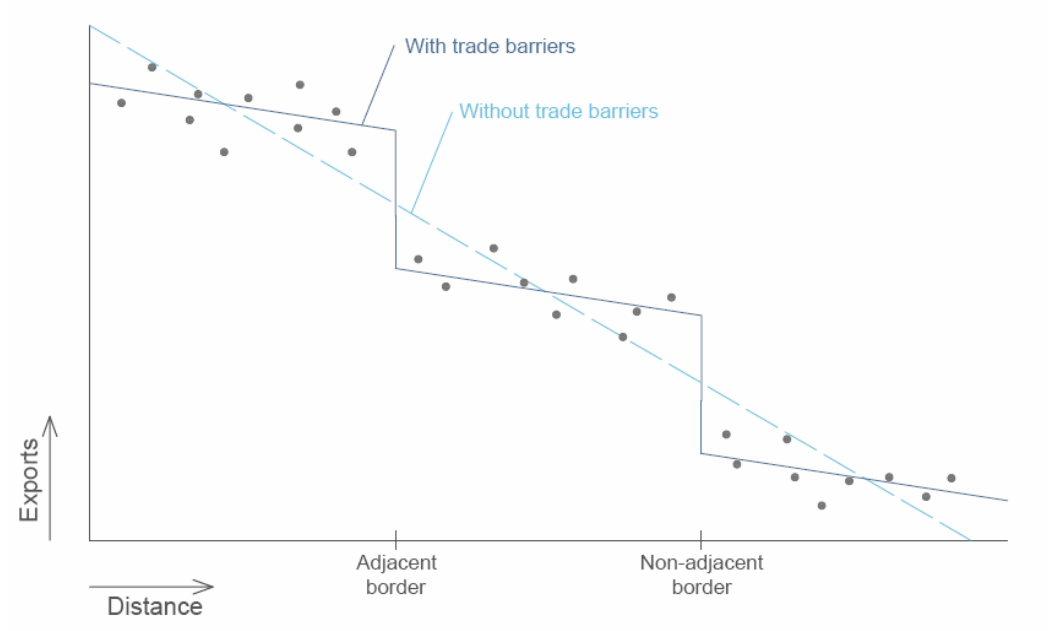
Figure 1. Adjusting distance and exports with and without trade barriers (others things being equal) Previous studies focussed on the estimation of the border effect from the home bias viewpoint, i.e., they were interested in knowing how much a region trades more within its country than with foreign regions. In contrast, our interest here is to ascertain the border effect, i.e., to what extent trade between foreign areas decreases due to the existence of an international border between them, other things being equal. For this reason, our dummy variable border was built the opposite way, i.e. using a value of 1 when the destination country is different from the country of origin, and 0 otherwise. Similarly, our dummy variable non-adjacency is 0 when two countries share a border and 1